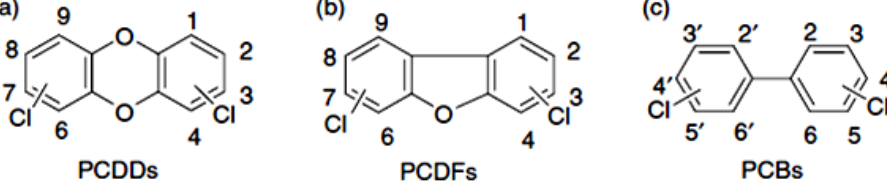
Figure 1. Basic chemical structure of polychlorinated dibenzo-p-dioxins ( a ), polychlorinated dibenzofurans ( b ) and polychlorinated biphenyls ( c )